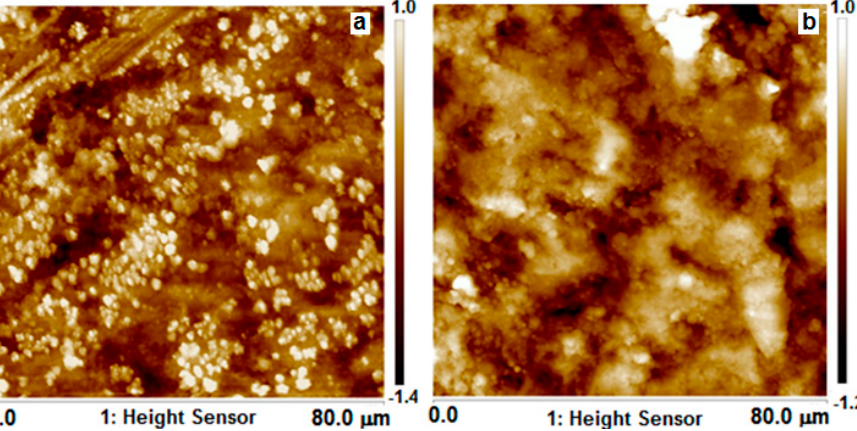
Figure 6. Two-dimensional atomic force microscopy (AFM) images of copper ( a ) in 1 M HCl, and ( b ) in 1 M HCl with 1000 ppm of P. ginseng inhibitor.